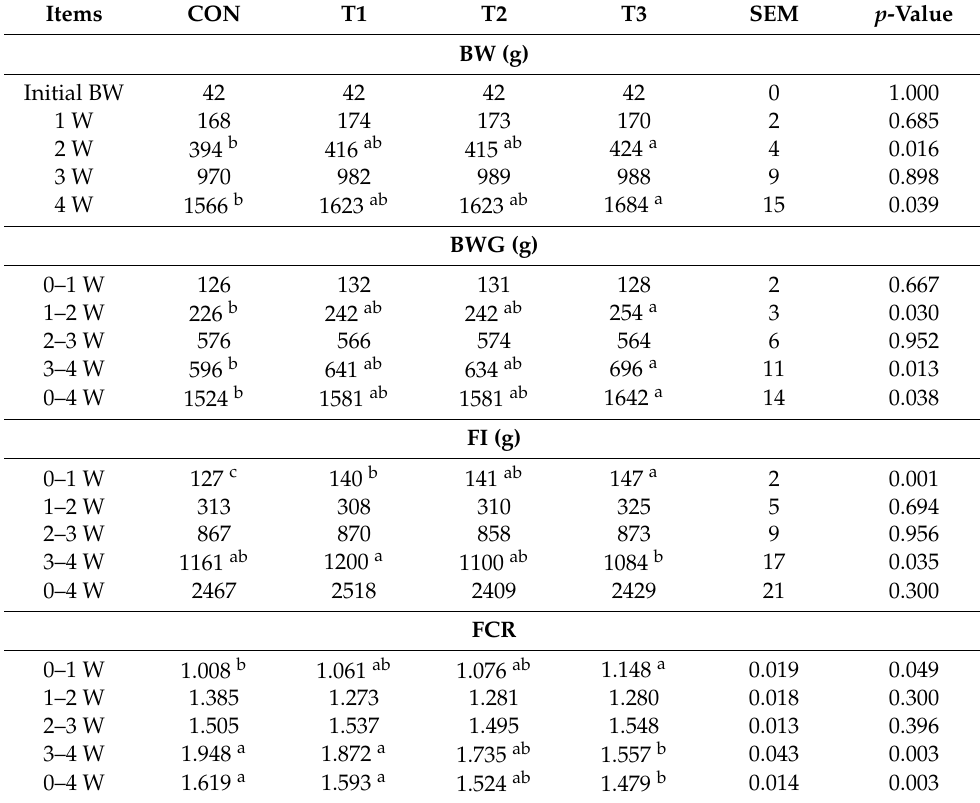
Table 6. Effects of full-fat almonds on growth performance in broiler